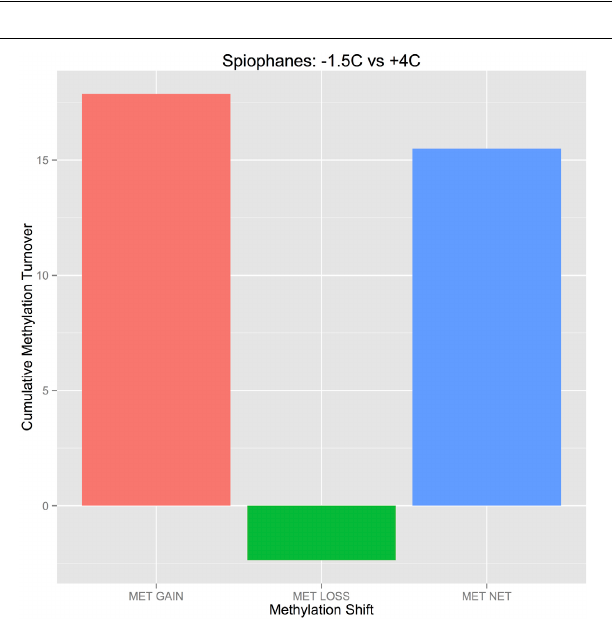
FIGURE 6 | Distributions of the magnitude of the methylation changes for each CpG site divided into gain and loss components.